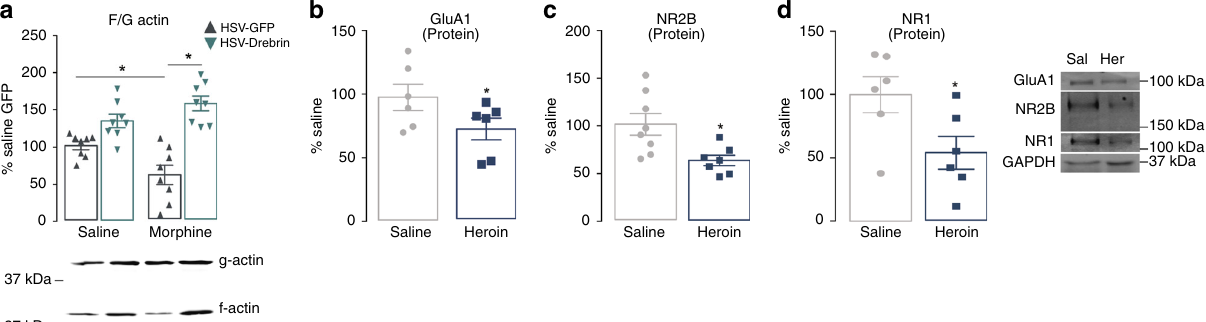
Fig. 4 Drebrin restores opiate-induced de fi cits in synaptic plasticity. a Intra-NAc expression of HSV-drebrin rescues morphine-induced changes in F/G- actin ratios (two-way ANOVA: drug effect, F 1,28 = 0.979, P > 0.05; virus effect, F 1,28 = 45.14, P < 0.01; interaction, F 1,28 = 10.62, P < 0.01; saline-GFP vs morphine-GFP, P = 0.005; morphine-GFP vs morphine-drebrin, P < 0.0001; saline-GFP vs morphine-drebrin, P = 0.0004; saline-GFP vs saline-drebrin, P = 0.02; n = 8 per group). Surface protein expressio n of AMPA receptor subunit GluA1 (Student ’ s t-test: t 10 = 1.949, P < 0.05, n = 6 per group) ( b ) and NMDA receptor subunits NR2B (Student ’ s t-test: t 13 = 2.856, P < 0.05, n = 7 – 8 per group) ( c ) and NR1 (S t udent ’ s t-test: t 10 = 2.405, P < 0.05, n = 6 per group) ( d ) in the NAc following heroin SA. Data are expressed as means ± SEMs. * P <